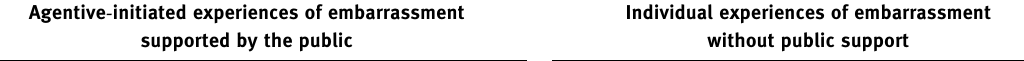
Table 1: Agentive experiences of embarrassment Agentive - initiated experiences of embarrassment supported by the public